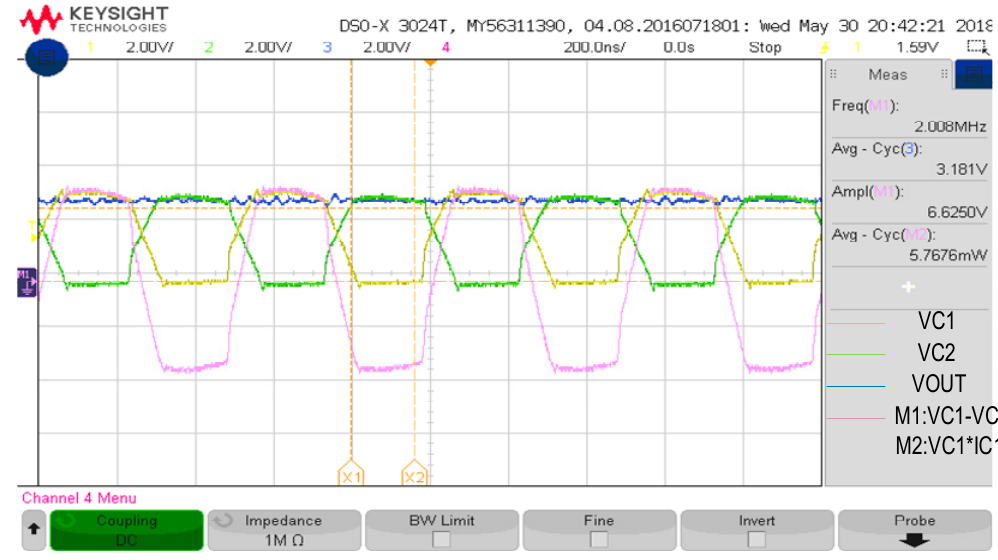
Figure 29. Actual measurement board ( 𝑅 (cid:3013) = 1 kΩ ).